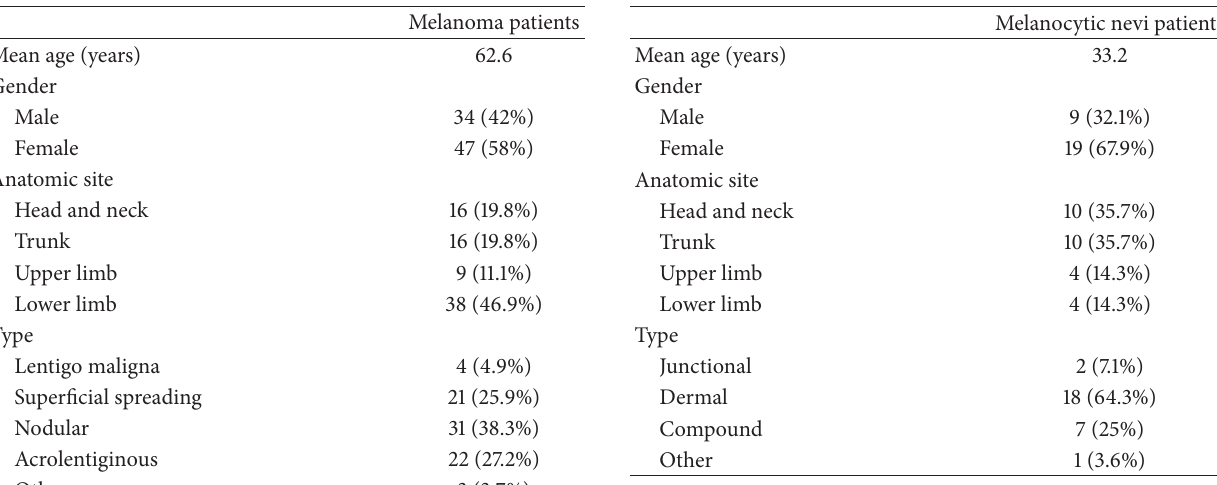
Table 1: Clinical data of melanoma patients. Table 2: Clinical data of melanocytic nevi